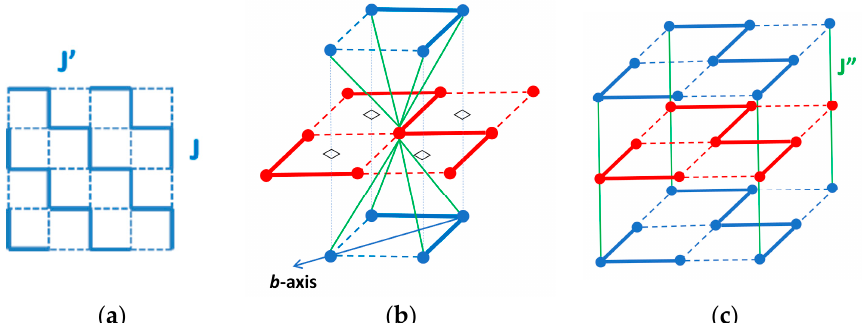
Figure 7. ( a ) Spatially anisotropic zig-zag square lattice interpolates between the chain ( R = J’ / J = 0) and the isotropic square lattice ( R = 1); ( b ) Position of adjacent layers (blue) in Cu(en)(H 2 O) 2 SO 4 with respect to the central 2D layer (red). Diamonds denote projections of the positions of blue circles into the central layer; ( c ) Position of adjacent layers (blue) in the verdazyl radical with respect to the central 2D layer (red). In ( b ) and ( c ), the inter-layer exchange couplings J” are depicted by green lines (see section 2.3).